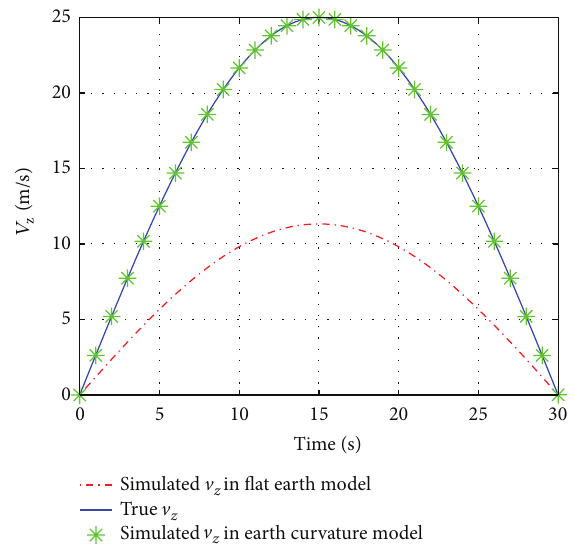
Figure 14: The comparison of V 𝑧 calculated by two kinds of earth models.